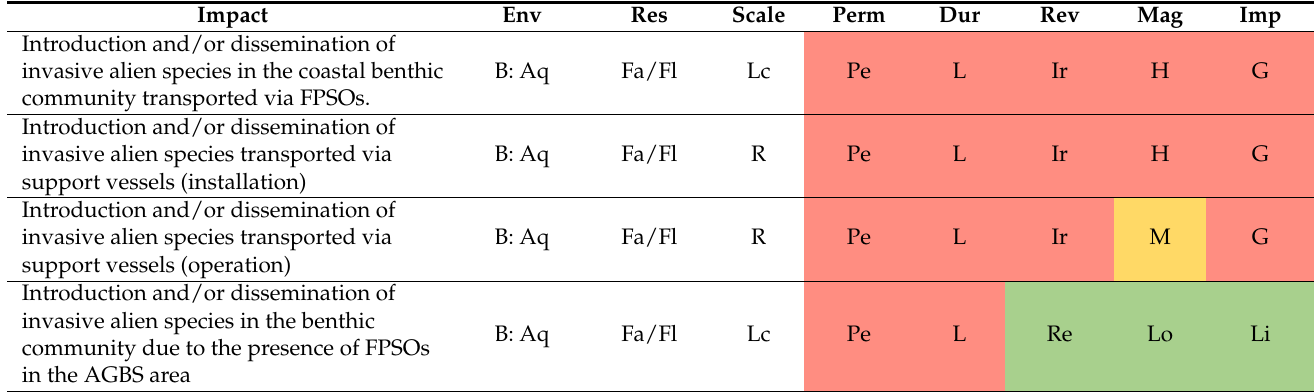
Table 11 lists the relevant potential environmental impacts that can be caused during Stage 3. The key is as follows: Environment (Env): Biotic (B) or Physical (P), Aquatic (Aq), Terrestrial (Te), Aerial (Ae); Resource (Res): Fauna (Fa), Flora (Fl), Air (Ar), Earth (Ea); Water (W); Scale: Local (Lc), Regional (R), Superregional (SR); Permanence (Perm): Temporary (T), Permanent (Pe); Duration (Dur): S, M, L; Reversibility (Rev): Re, PR, Ir; Magnitude (Mag): Lo, M, H; Importance (Imp): Li, M, G. Created based on